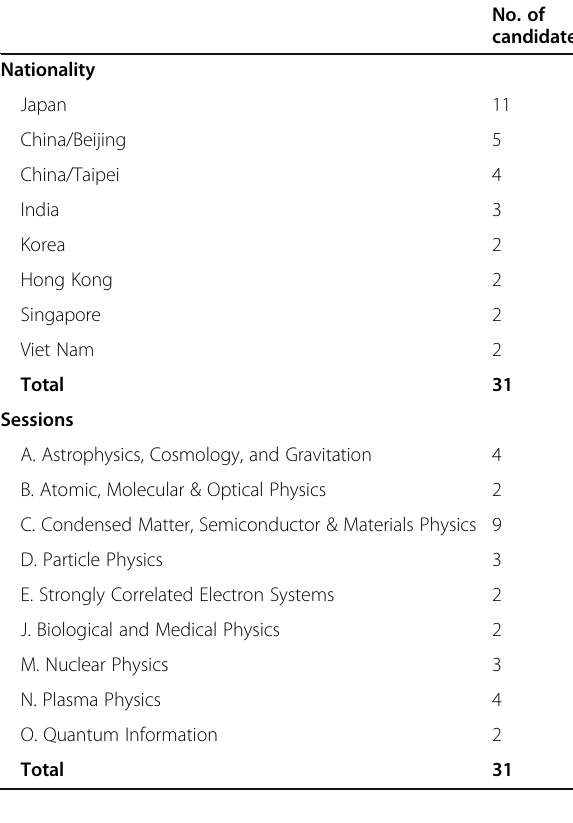
Table 1 The nationalities and the sessions of the 2021 CN Yang Award